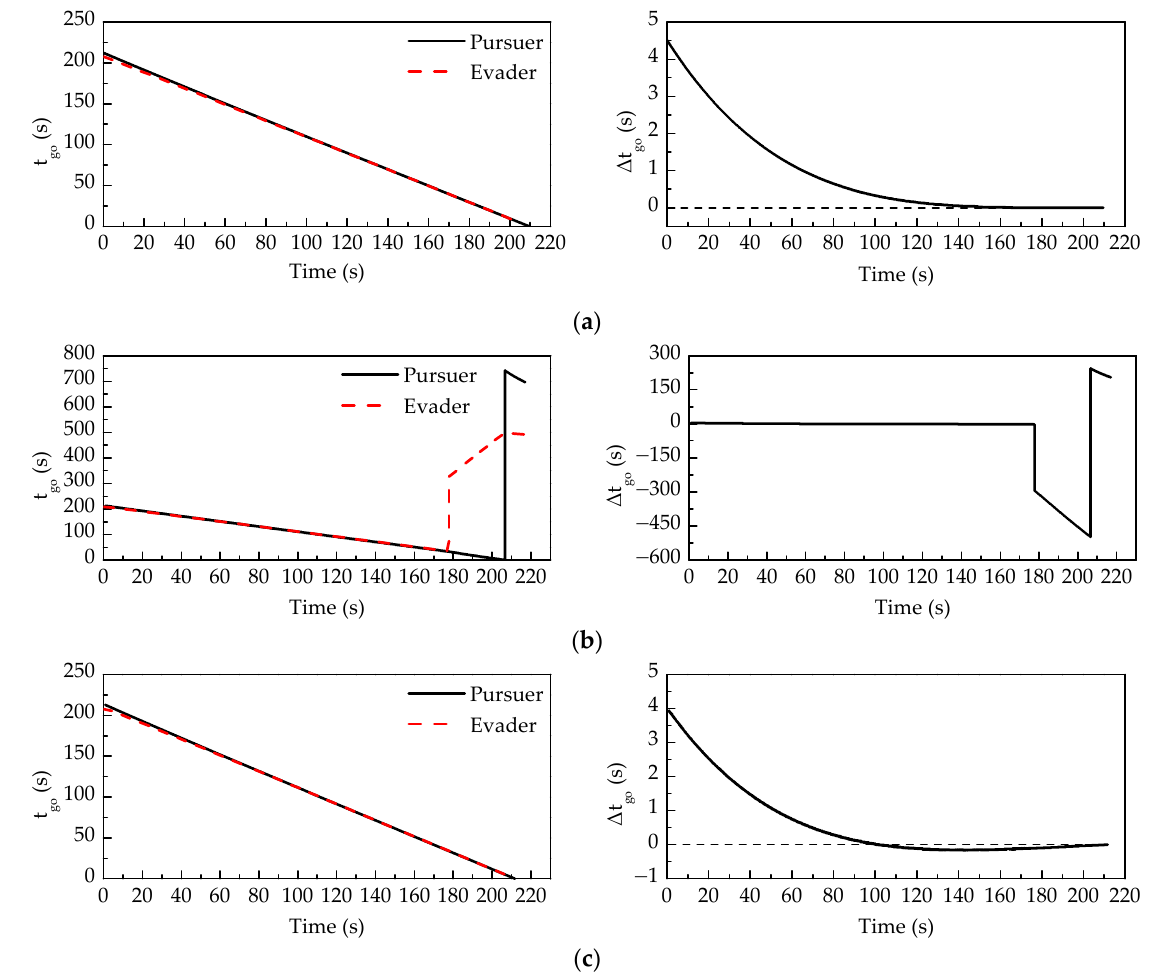
Figure 9. The average t go and ∆ t go of 100 Monte Carlo runs in the scenario that the pursuer plays ( a ) without time delay; ( b ) without compensation for time delay; and ( c ) with compensation for time delay.